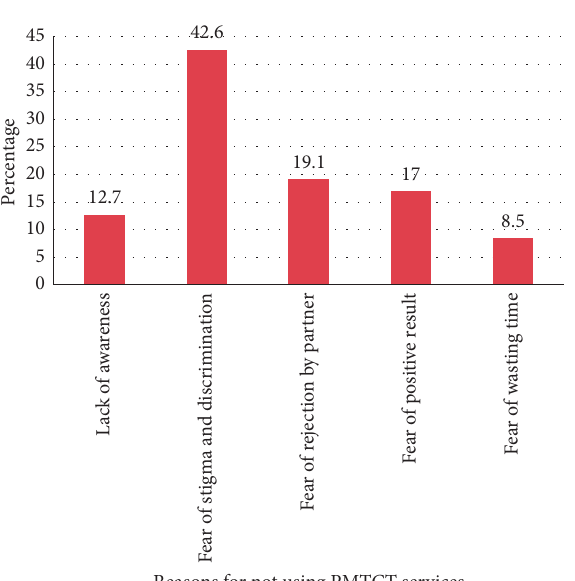
Figure 2: Reasons for not using PMTCT services among pregnant women attending ANC at public health facilities, Debre Berhan Town, June